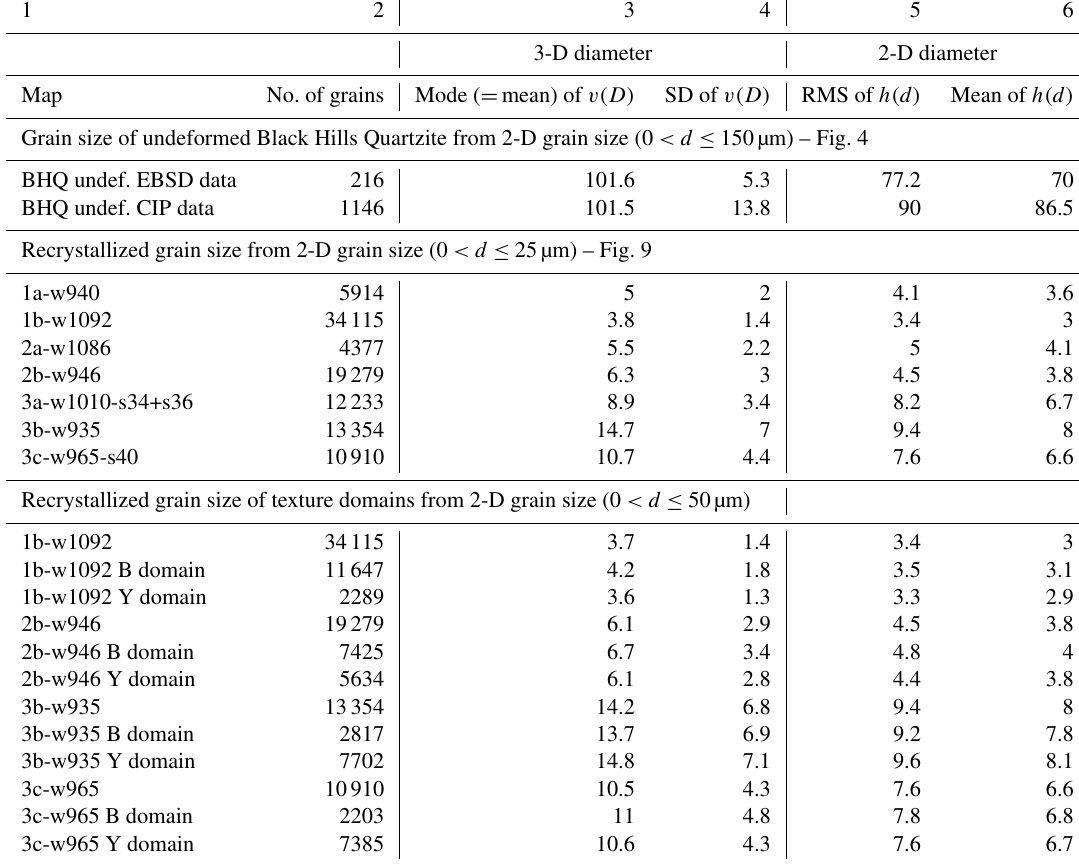
Table 2. Grain size